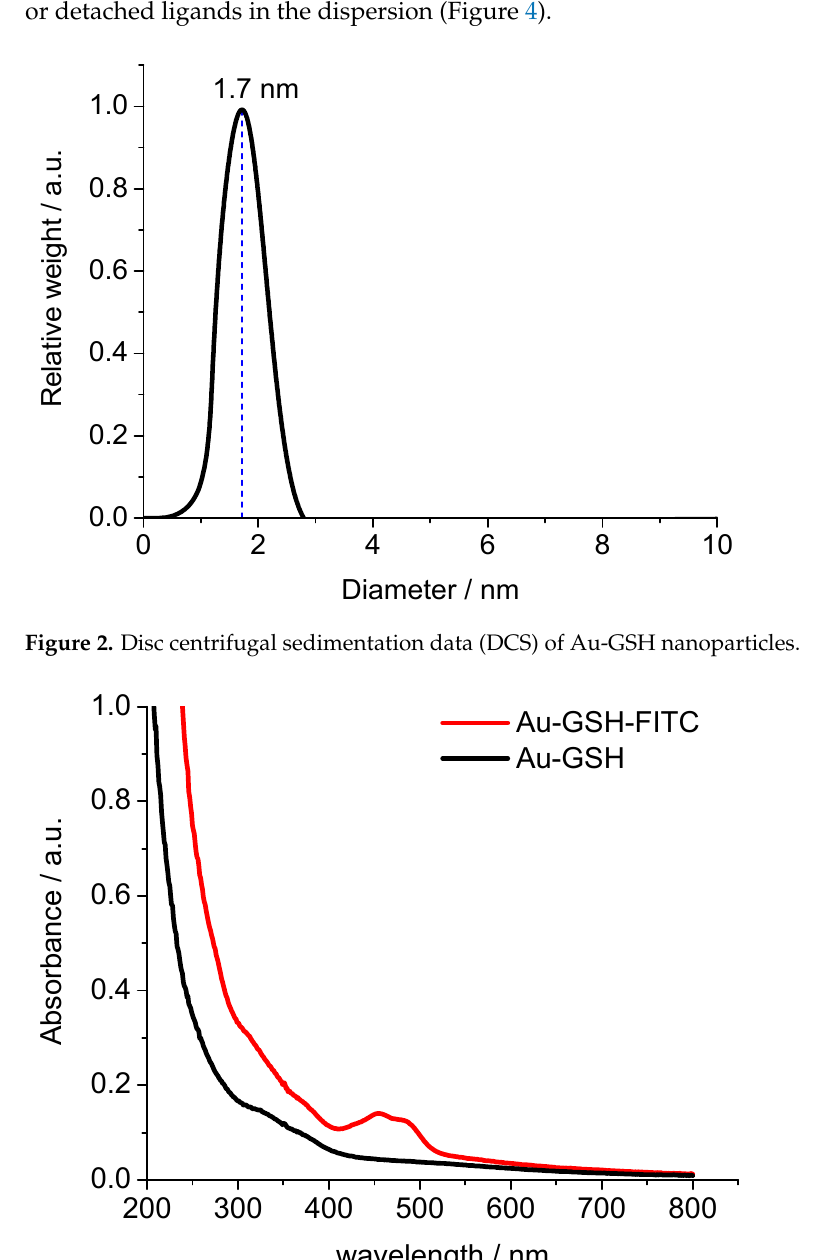
Figure 3. UV-Vis spectra of glutathione-functionalized ultrasmall gold nanoparticles before (black) and after labelling with NHS fluorescein (FITC) (red).